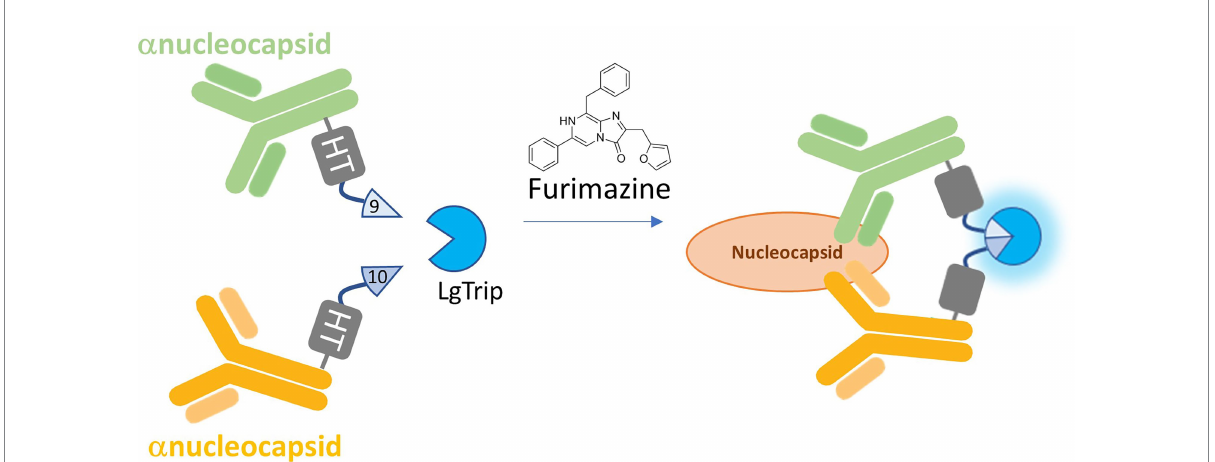
FIGURE 1 Schematic of the ternary Nluc reporter immunoassay. β 9 and β 10 peptides are chemically conjugated via HaloTag (HT) to a pair of antibodies that recognize separate epitopes on the target analyte. Binding to the analyte brings the antibodies and their respective peptide subunits into close proximity. With the addition of LgTrip and the furimazine substrate, complementation of the active ternary Nluc complex occurs, producing bioluminescence.